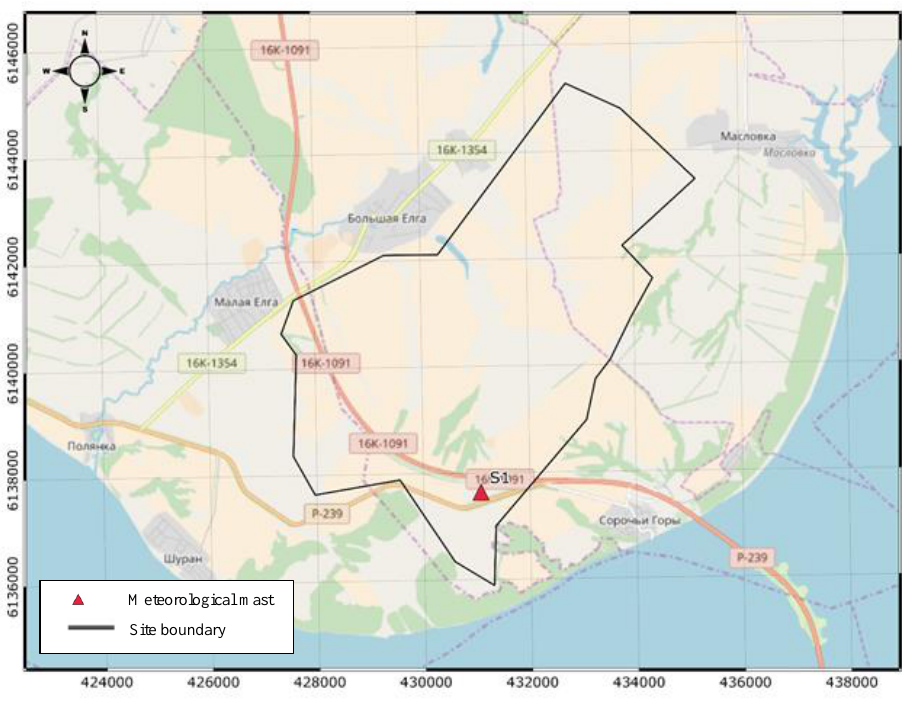
Figure 1. Map of Sorochi Gory wind farm site